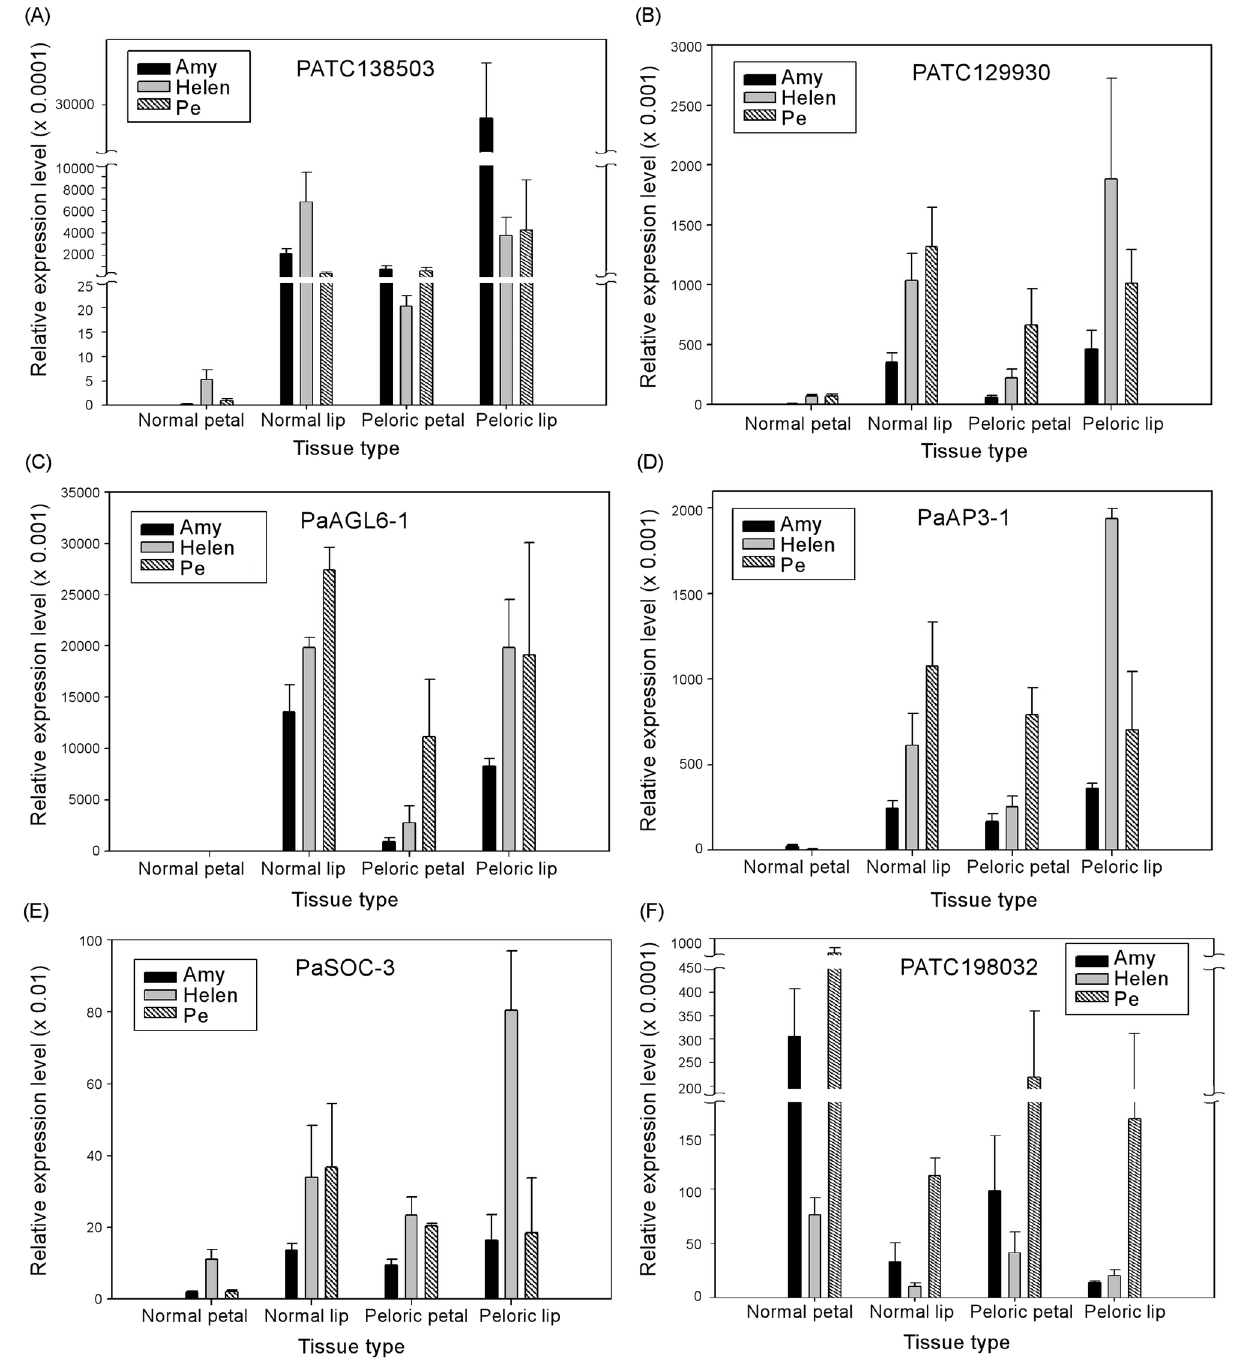
Figure 6. Quantitative PCR results to validate genes specifically expressed during morphological differentiation. Amy: P. Nobby’s Amy; Helen: Dtps I-Hsing Helen; Pe: Phalaenopsis equestris . Validated genes include, (A) PaMTN3 (PATC138503); (B) PaZF (PATC129930); (C) PaAGL6-1 ; (D) PaAP3-3 ; (E) PaSOC1-3 ; (F) PATC198032. Primers used in the PCR reactions are listed in Table S3 in File S1.